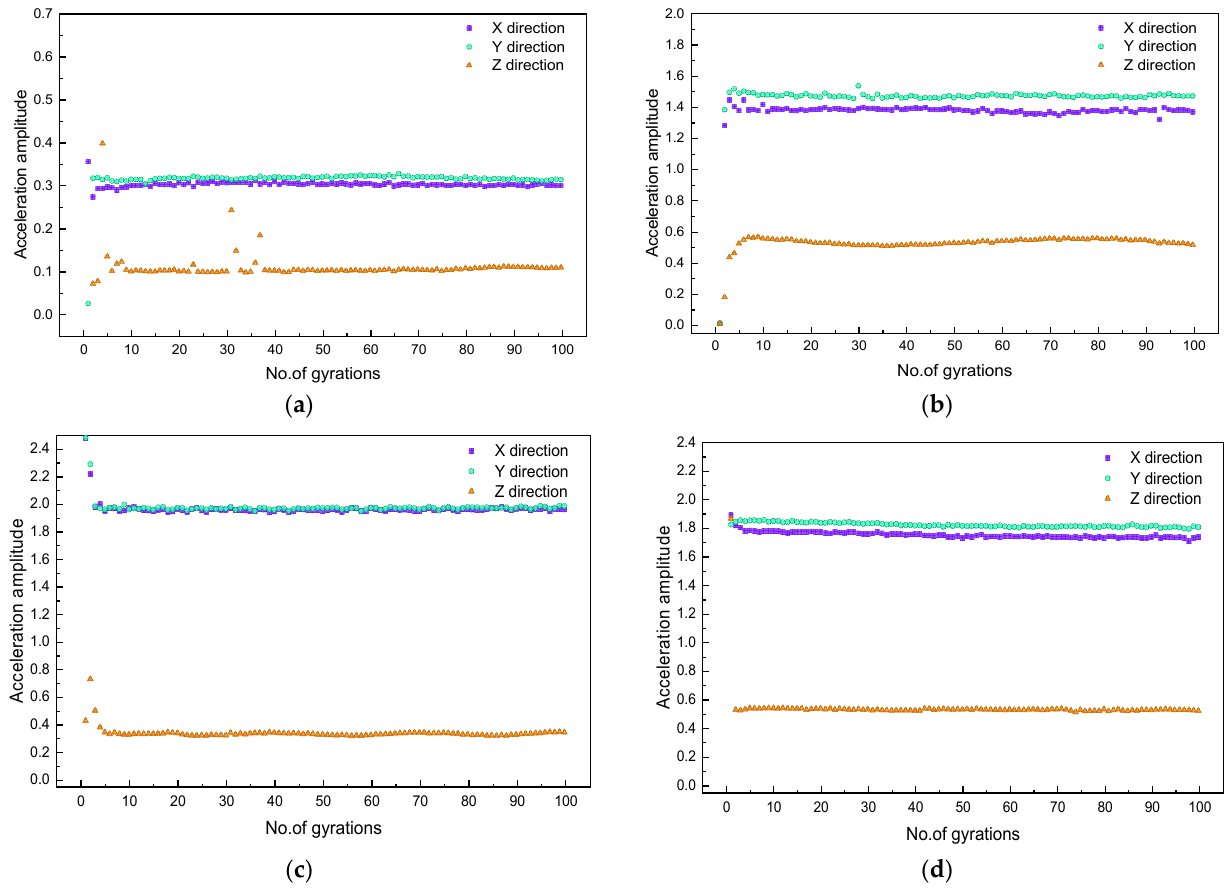
Figure 15. Acceleration characteristic value results measured at four different positions of the specimen with optimal combination of gyratory parameters: ( a ) lower center, ( b ) middle center, ( c ) upper center, and ( d ) center side.